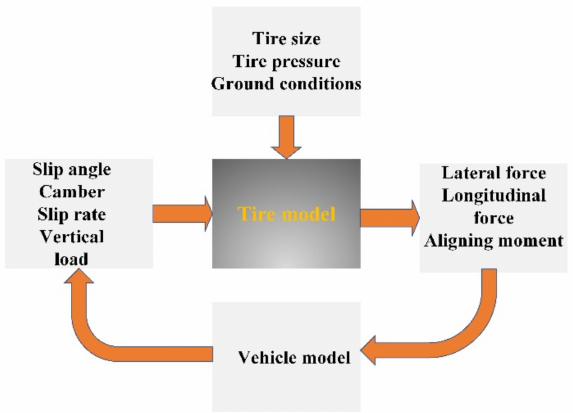
Figure 4. Relationship between tire model and vehicle